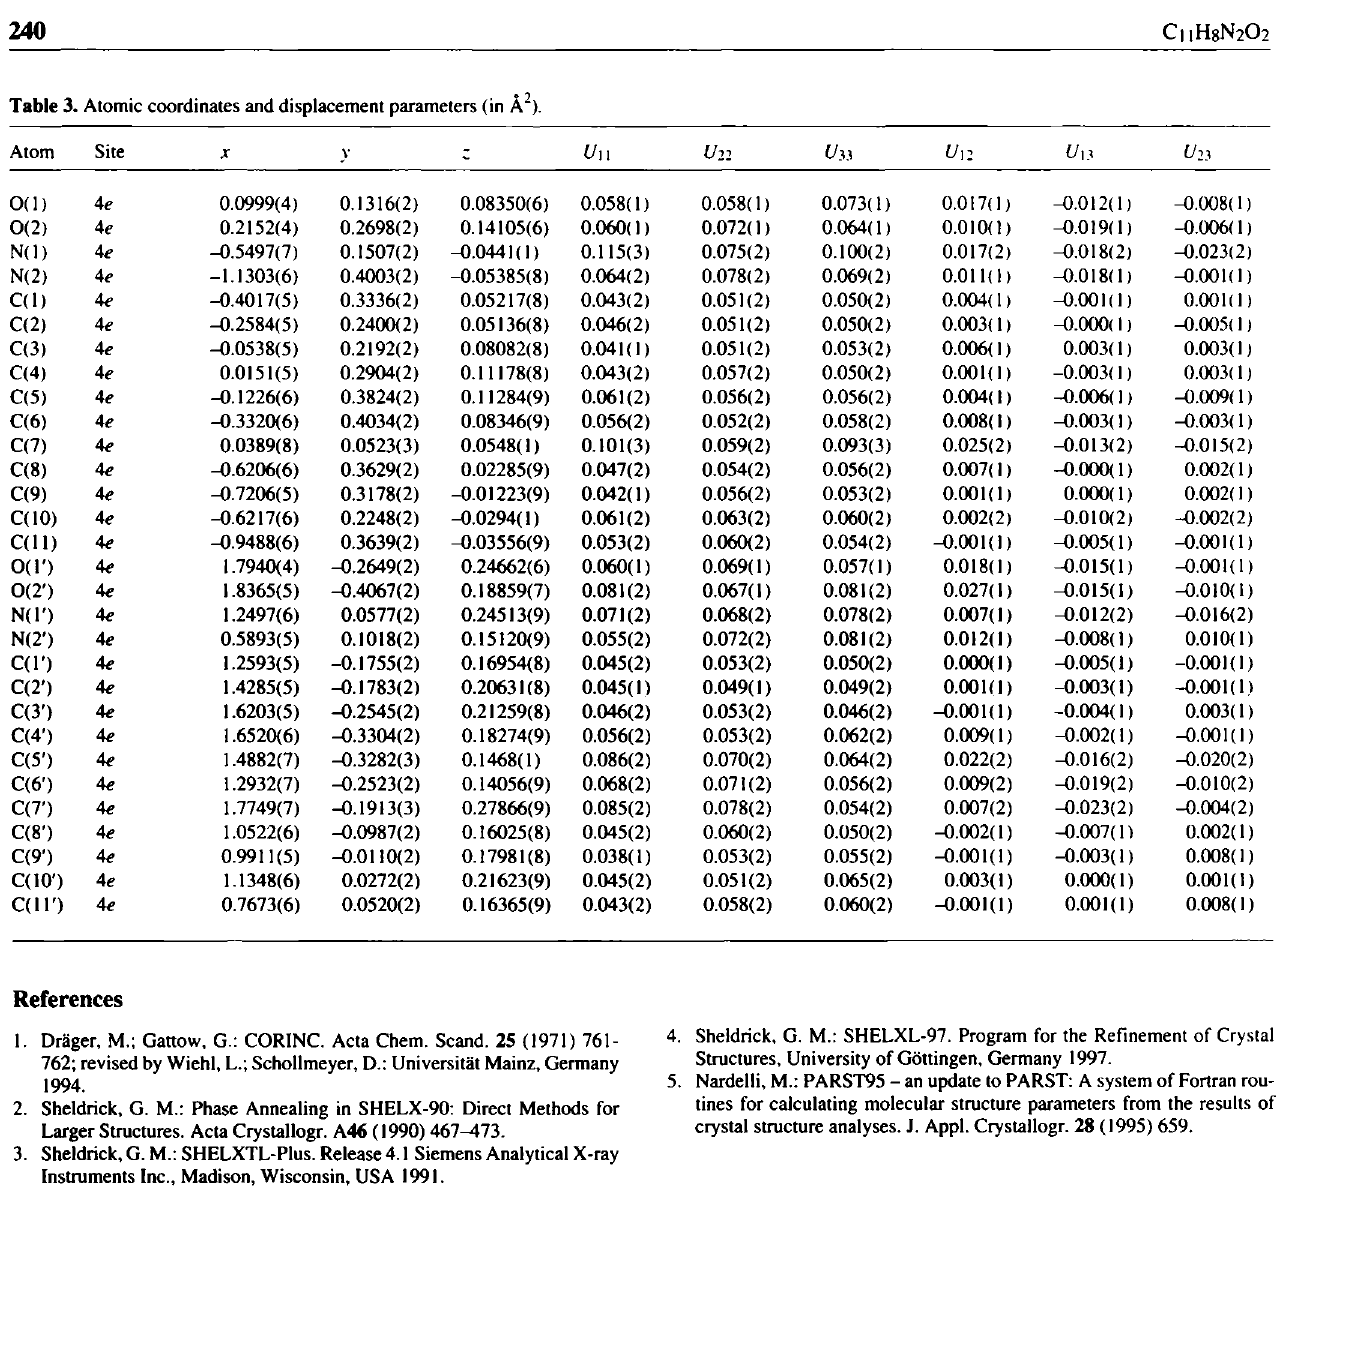
Table 3. Atomic coordinates and displacement parameters (in Ä 2